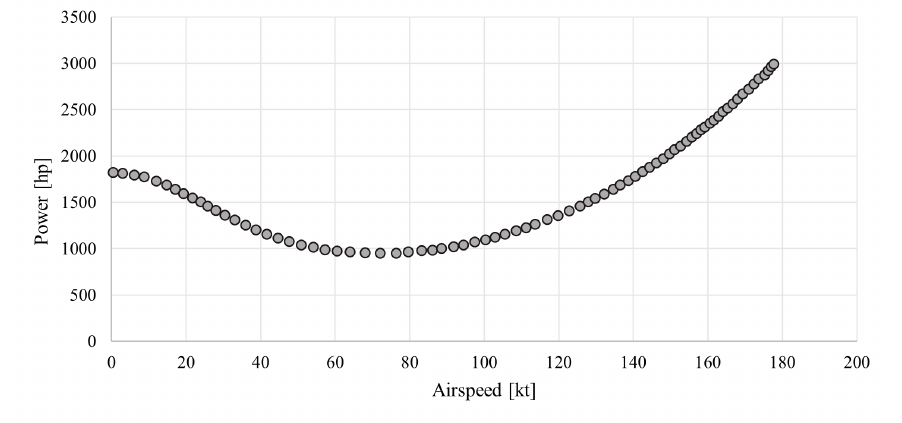
Figure 1. The relationship between helicopter power and airspeed. Based on the graph presented in